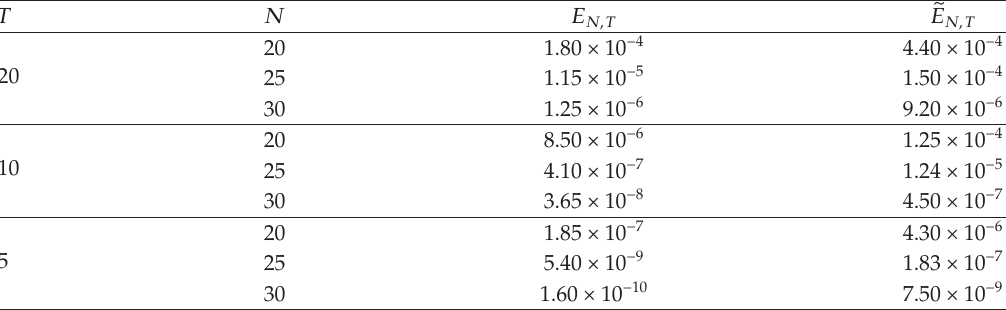
Table 1: The maximum absolute errors E N,T and